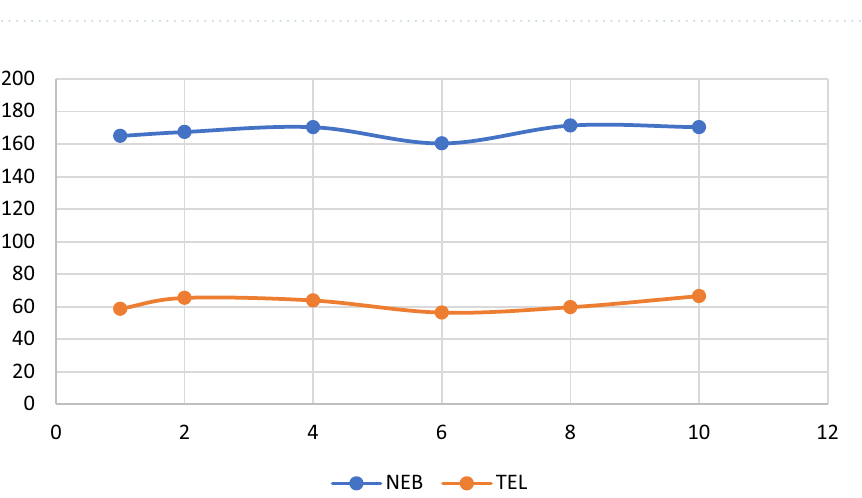
Figure 7. Effect of pH on the relative synchronous fluorescence intensity of (100.0 ng/ mL) for each NEB and TEL.